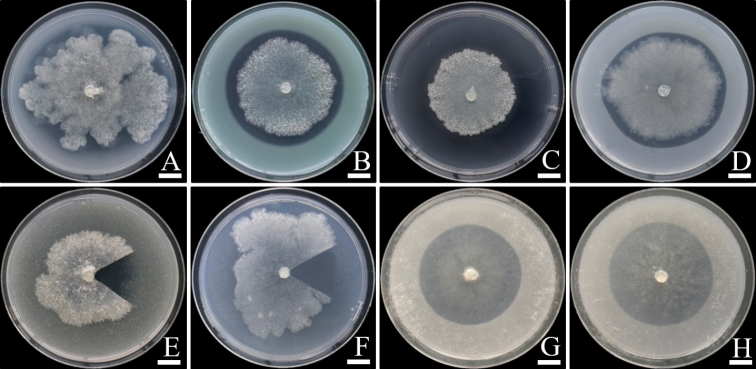
Solubilization of non-soluble minerals in agar media by Apophysomycesthailandensis SDBR-CMUS26 (holotype). A Ca3(PO4)2B CuCO3•Cu(OH)2C CuO D ZnCO3E FePO4F MnO G Feldspar H Kaolin. Scale bars: 10 mm. Fungal colonies in E and F were cut for the solubilization area (halo zone) observation.